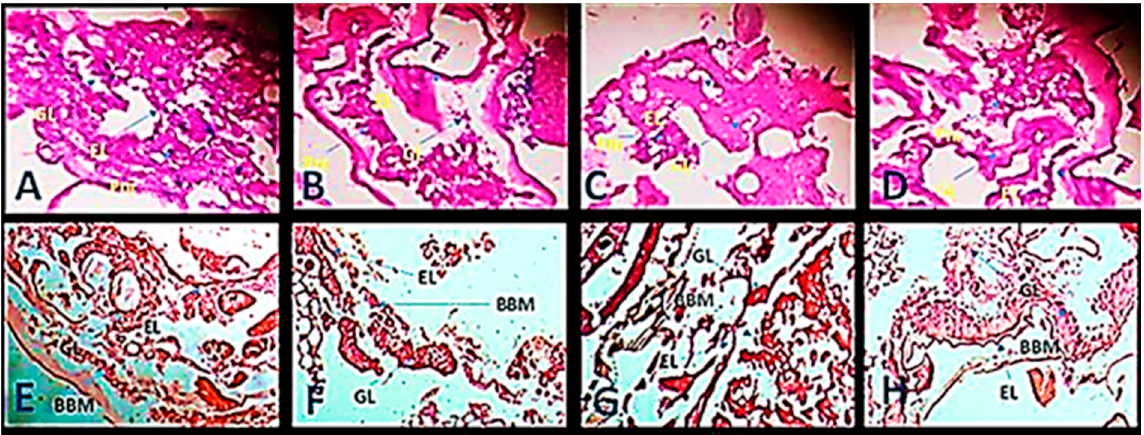
Figure 11. Gut-histological analysis of cross-section of the midgut of fourth instar larvae of A. aegypti after treatment with ( A ) control, ( B ) NH-EDx (500 ppm), ( C ) n -HDa (5 ppm), and ( D ) n -ODa (5 ppm) and of fourth instar larvae of S. litura after treatment with ( E ) control, ( F ) NH-EDx (500 ppm), ( G ) n -HDa (5 ppm), and ( H ) n -ODa (5 ppm). EL: epithelial layer; GL: gut lumen; Pm: peritrophic matrix; BBM: brush border membrane.